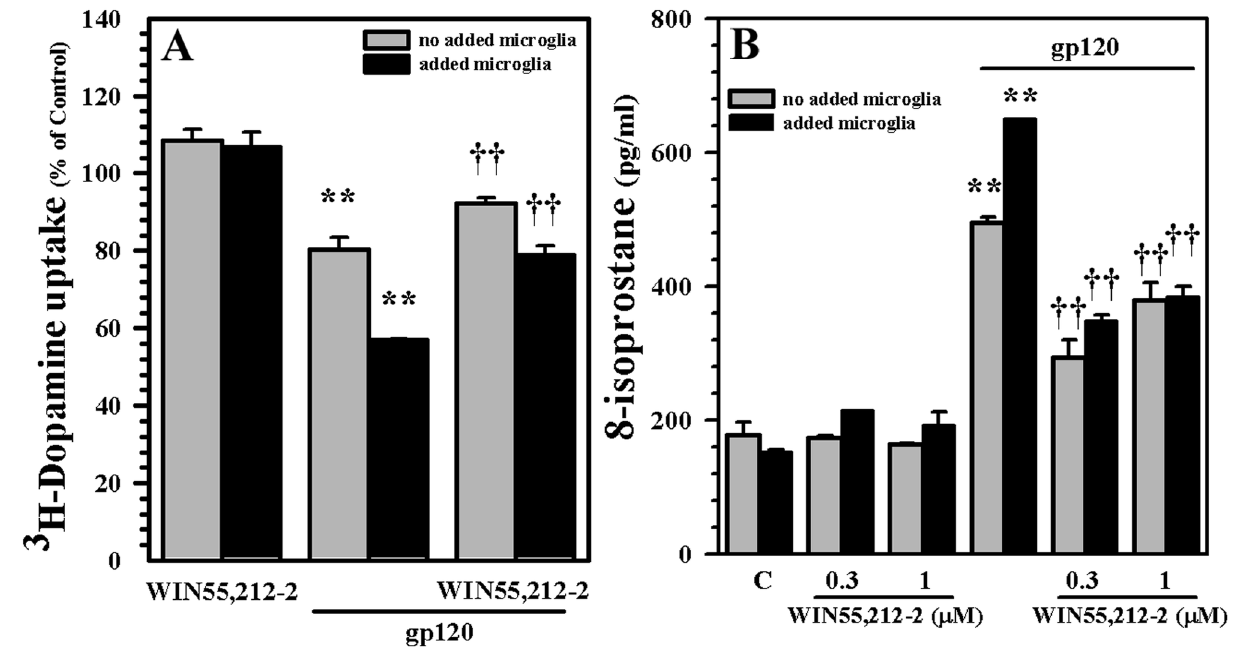
Figure 8. Blockade of microglial-enhanced gp120-induced decrease of DA uptake and increase of lipid peroxidation. Additional human microglial cells (5x10 4 cells/well) were added to human mesencephalic neuronal/glial cultures for 3h followed by WIN55,212-2 (0.3 μM) pretreatment for 3h prior to gp120 treatment for 5 days. A ) DAT activity was measured by 3